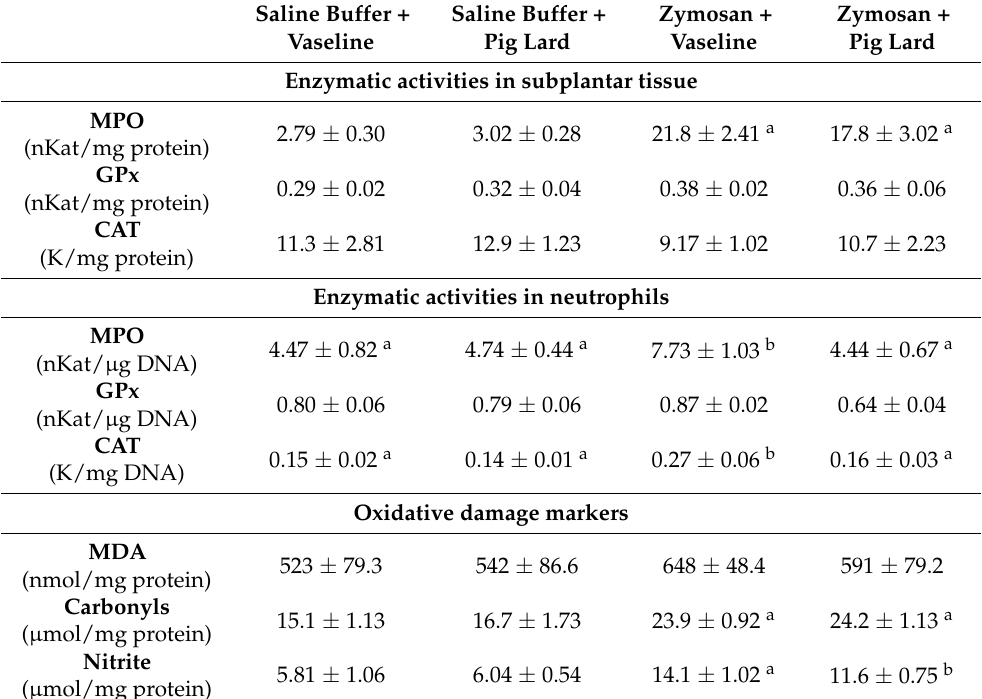
Table 1. Effects of pig lard treatment on antioxidant, pro-inflammatory, and oxidative damage markers in inflamed plantar tissues and